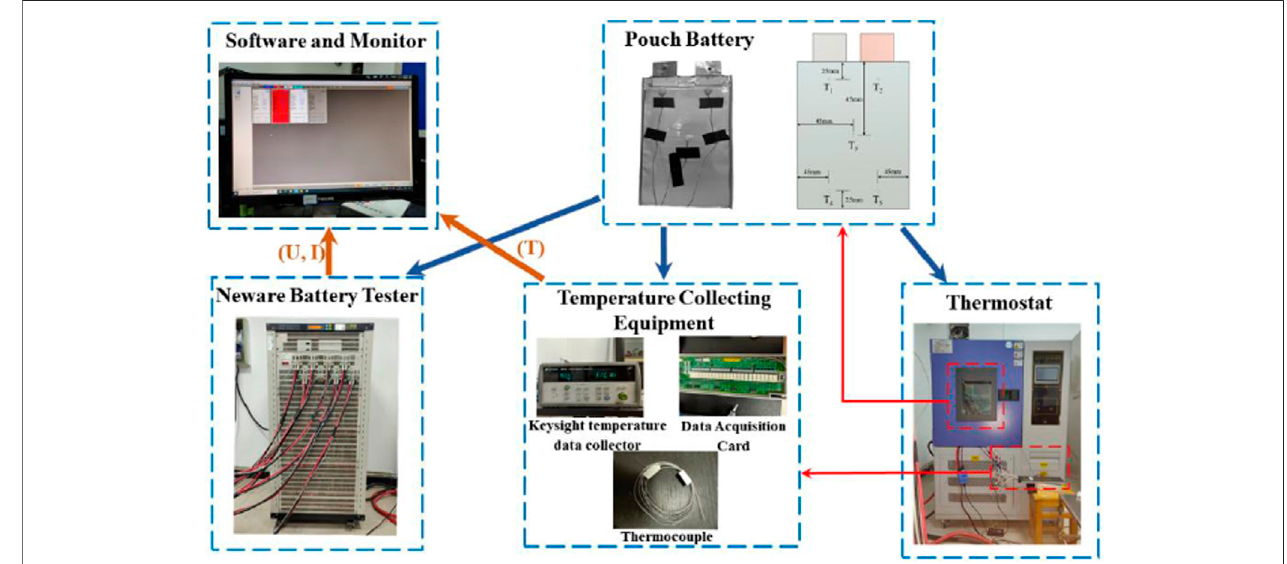
FIGURE 1 | Devices used in the cell experiment.